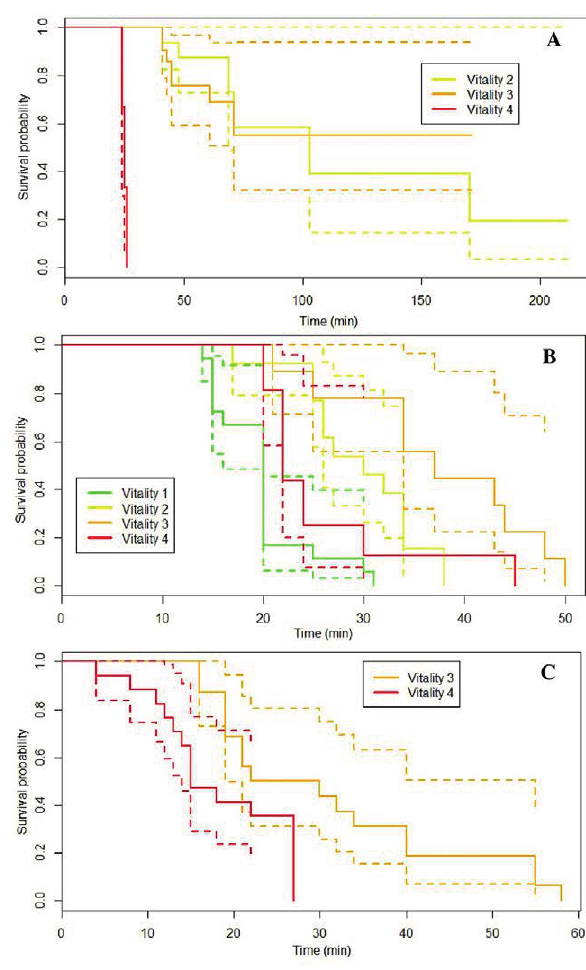
Fig. 3. – Results of Kaplan-Meier for Scyliorhinus canicula (A), Trachurus spp. (B) and Merluccius merluccius (C), with survival curves for each vitality category. Dashed lines represent 95% con- fidence